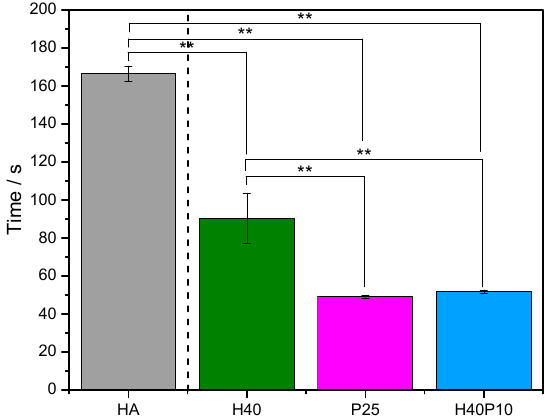
Figure 5. Initial setting times of pure inorganic reference HA in comparison to the composite formulations with 40 wt% HEMA (H40), HEMA in the same concentration combined with 10 wt% degradable cross-linker (H40P10) as well as a hydrogel phase produced out of 25 wt% polymer (P25). ** p < 0.001.